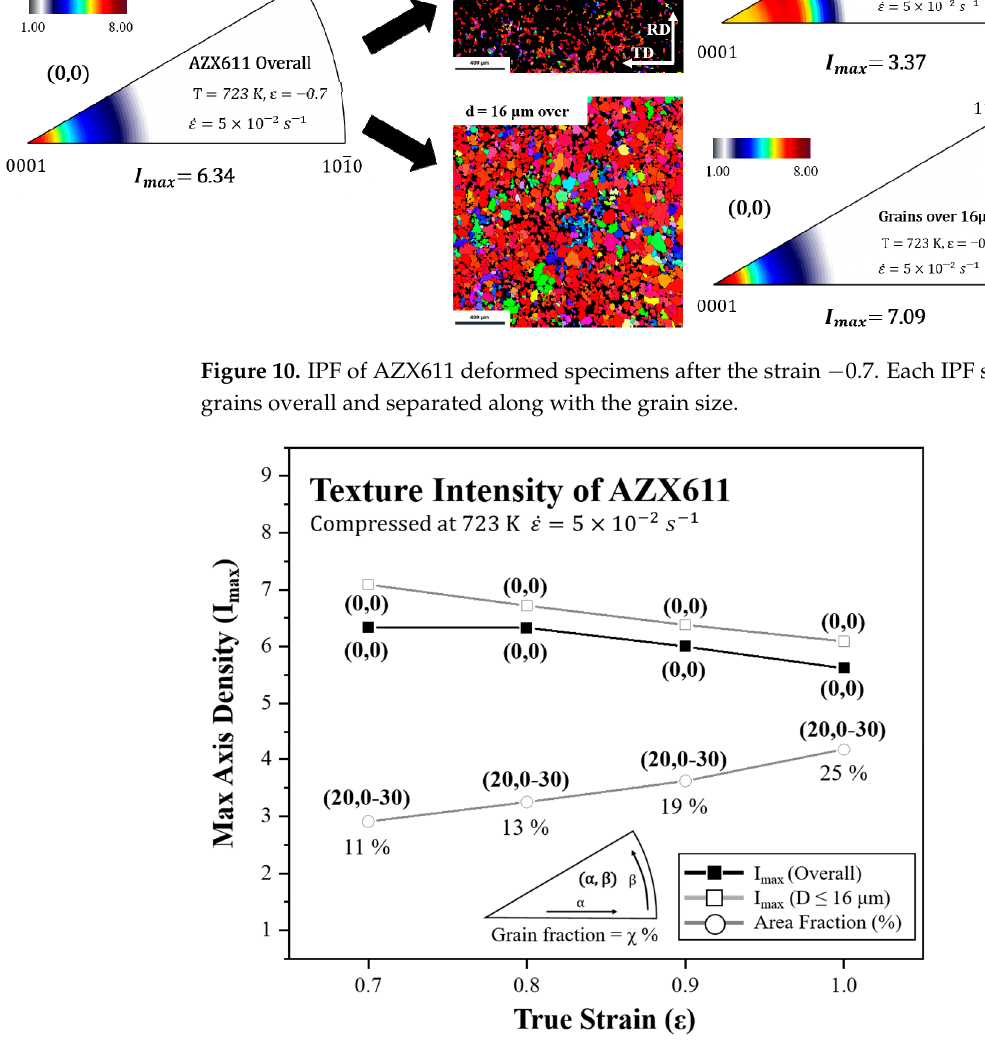
Figure 11. The graph showing fraction and texture intensity of grains under 16 μ